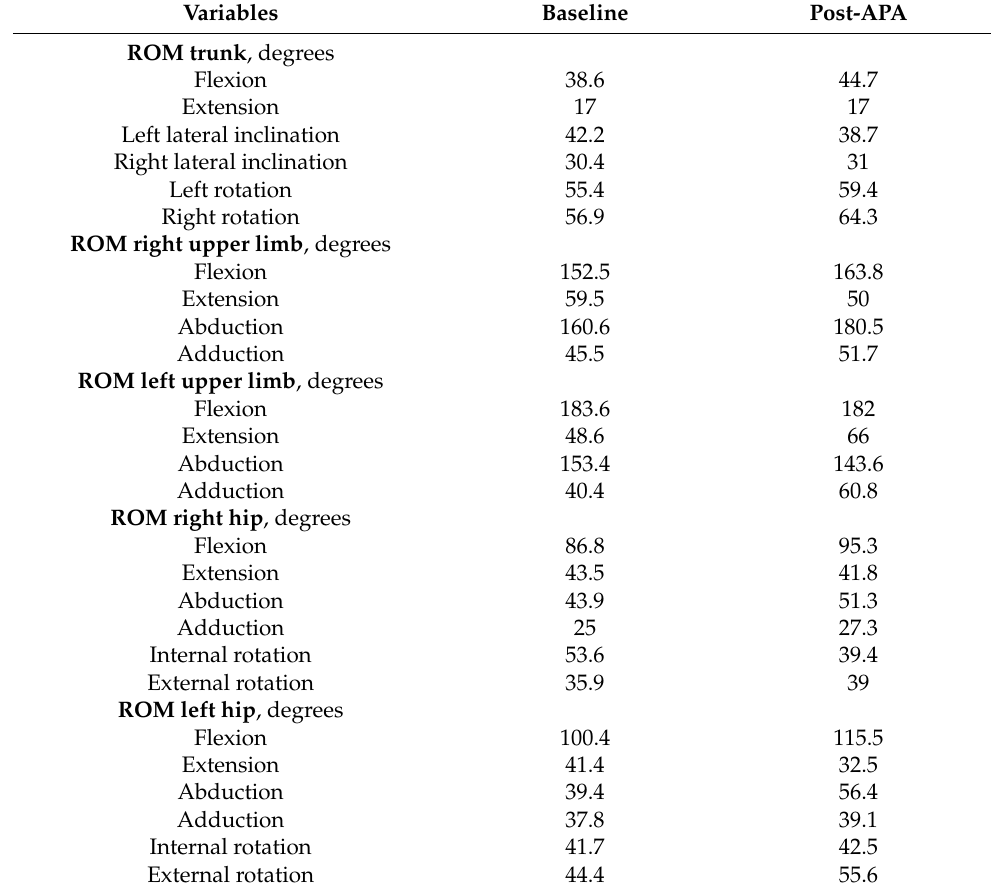
Table 1. Active range of motion test scores at baseline and post-adapted physical activity